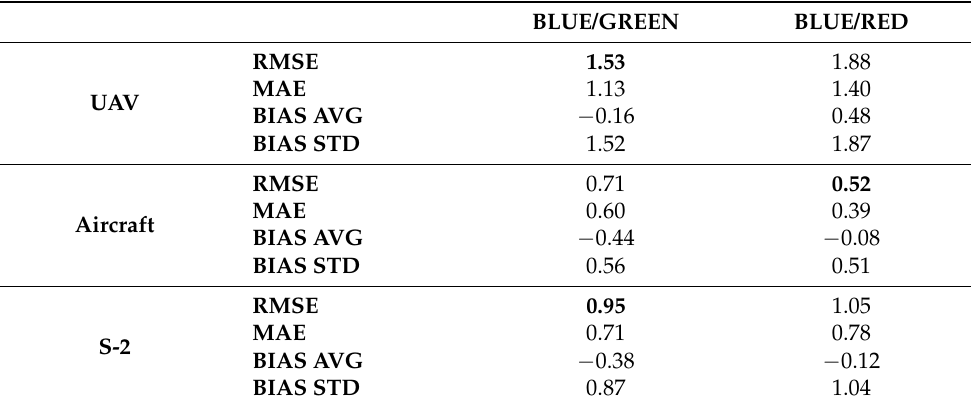
Figure 9. Results of the calibration phase, showing the regression between the blue/green ratio (represented with green dots) or the blue/red ratio (represented with red dots) and the depth of the calibration points sets for UAV, aircraft and S-2 orthophotos in Capo San Donato. The resulting R 2 values are reported in the legend of the graph. Table 3. Statistical parameters (in m): RMSE and MAE for the model validation and the average value and the standard deviation of the BIAS between the RDB and the GPs for the two band ratios and the three platforms in sandy areas in Capo San